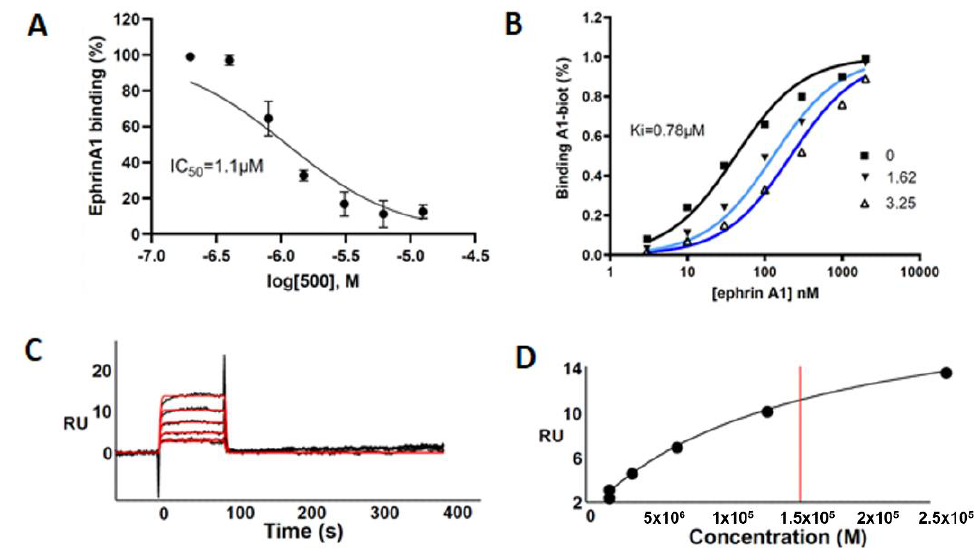
Figure 6. ( A ) UniPR500 dose-dependently displaces biotinylated ephrin-A1 from immobilized EphA2 receptor. ( B ) Saturation curves of biotinylated ephrin-A1-Fc on EphA2 in the presence of increasing concentration of UniPR500. The inhibition constant (Ki) was calculated using Prism non-linear regression analysis. ( C ) SPR sensorgrams for the binding of UniPR500 (25.0, 12.5, 6.25, 3.12, and 1.56 µ M from top to bottom) to sensorchip-immobilized EphA2-Fc. Black lines represent the experimental data; red lines represent the fits. ( D ) Steady-state analysis for the interaction of UniPR500 with sensorchip-immobilized EphA2 - Fc. The redline identifies the Kd. This value is in the same order of magnitude of the corresponding Kd value of 14.9 µ